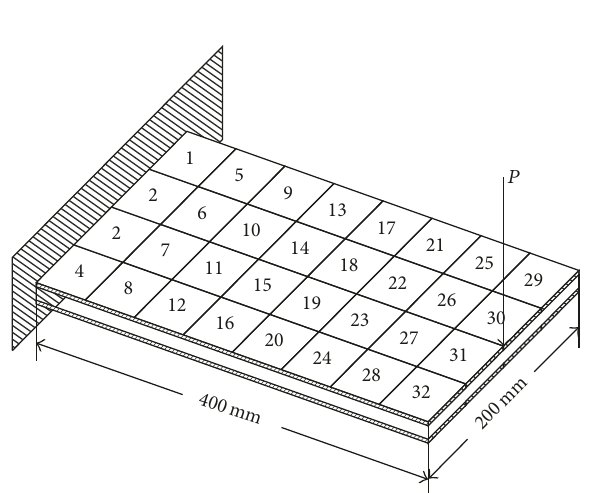
Figure 3: Finite element model of cantilever intelligent structural plate.